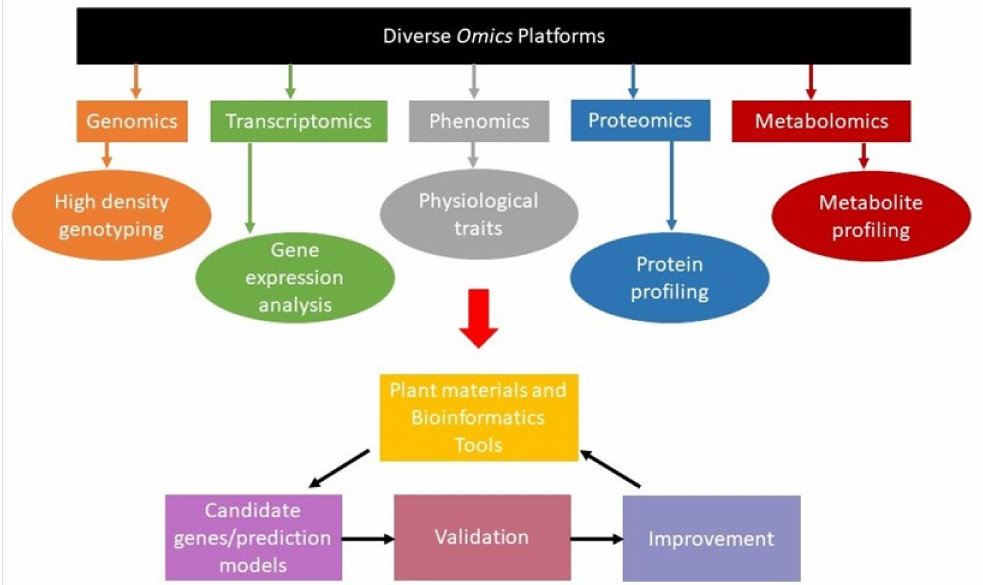
Figure 2. Graphical representation of the application of different omics approaches and their use in crop improvement.